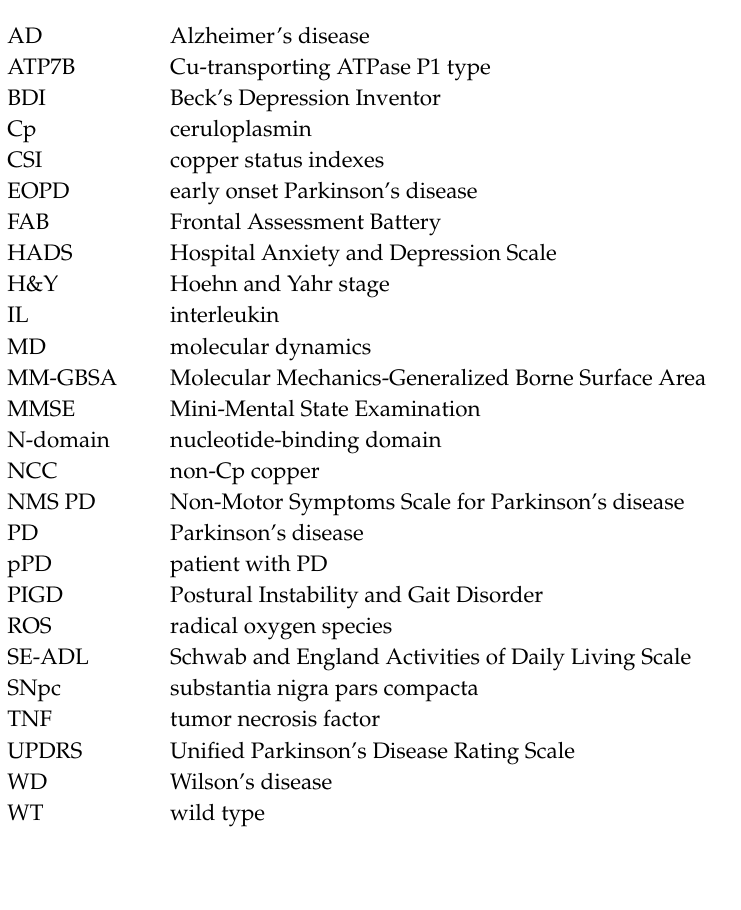
Table S1: MM-GBSA free energy per residue pair decomposition ( ∆ G, kcal / mol); Table S2: MM-GBSA free energy per residue decomposition ( ∆ G, kcal /